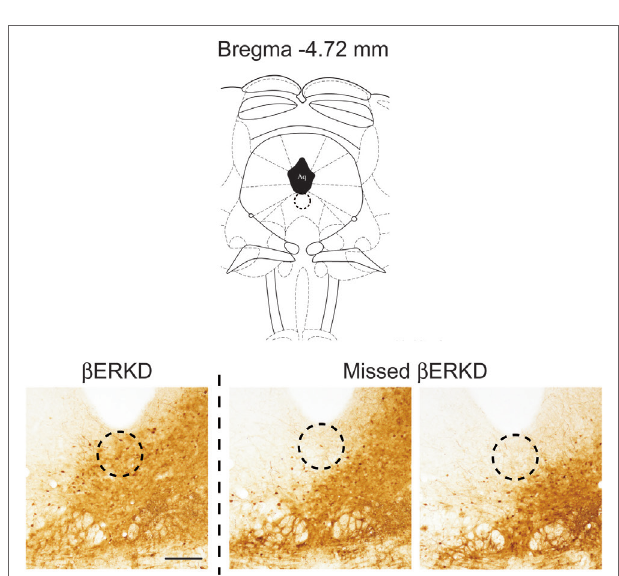
FigUre 4 | Comparison of distribution pattern of adeno-associated virus within the mediodorsal area of dorsal part of the dorsal raphe nucleus (Bregma − 4.72 mm) determined by green fluorescent protein immunohistochemistry in successful ER β knockdown ( β ERKD) (left) and missed β ERKD (middle and right) mice. The scale bar represents 200 µm.